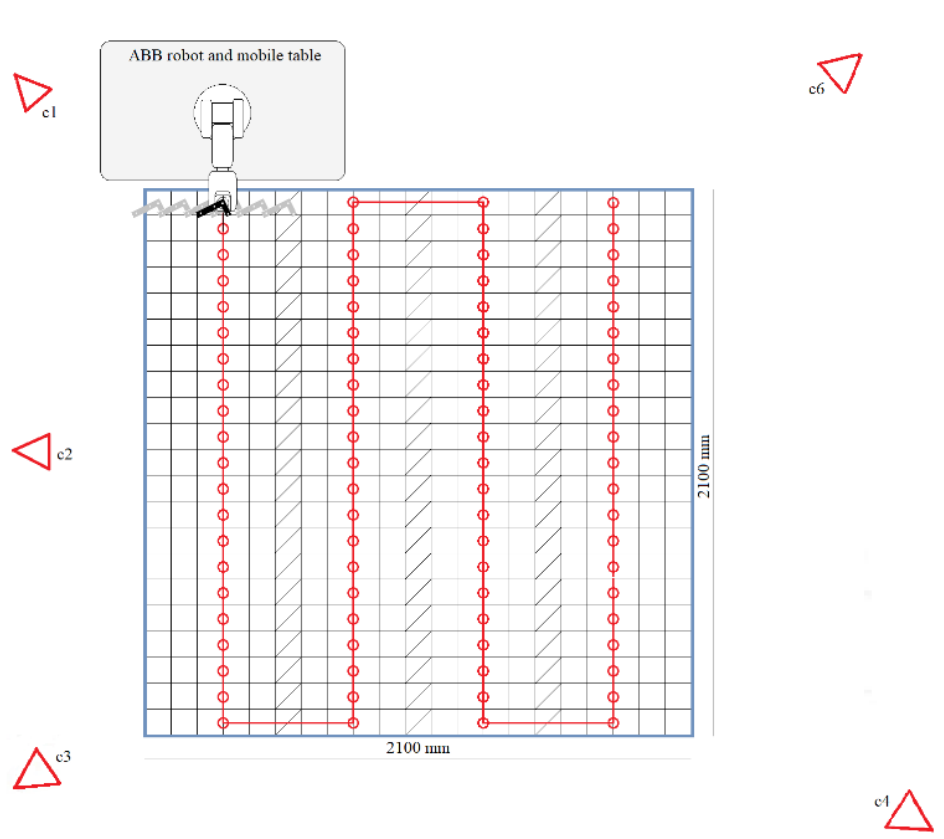
Figure 2. Robot motion test procedure. The red dots are the swept line’s centre, where the tool of the robot is relocated. The 5th camera, C5, is out of the image, 4.4 m in front of camera C2.